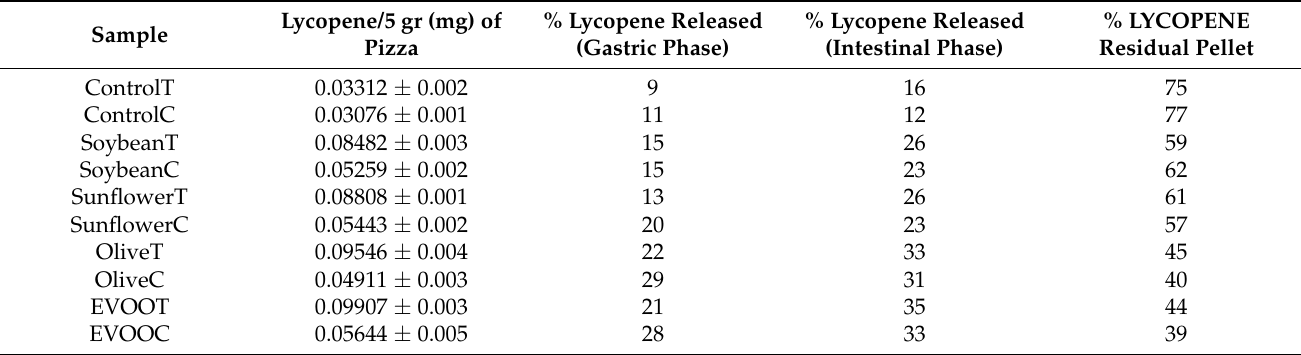
Table 2. Bioaccessibility of lycopene in the “marinara” pizzas expressed as percentage released at the gastric and intestinal